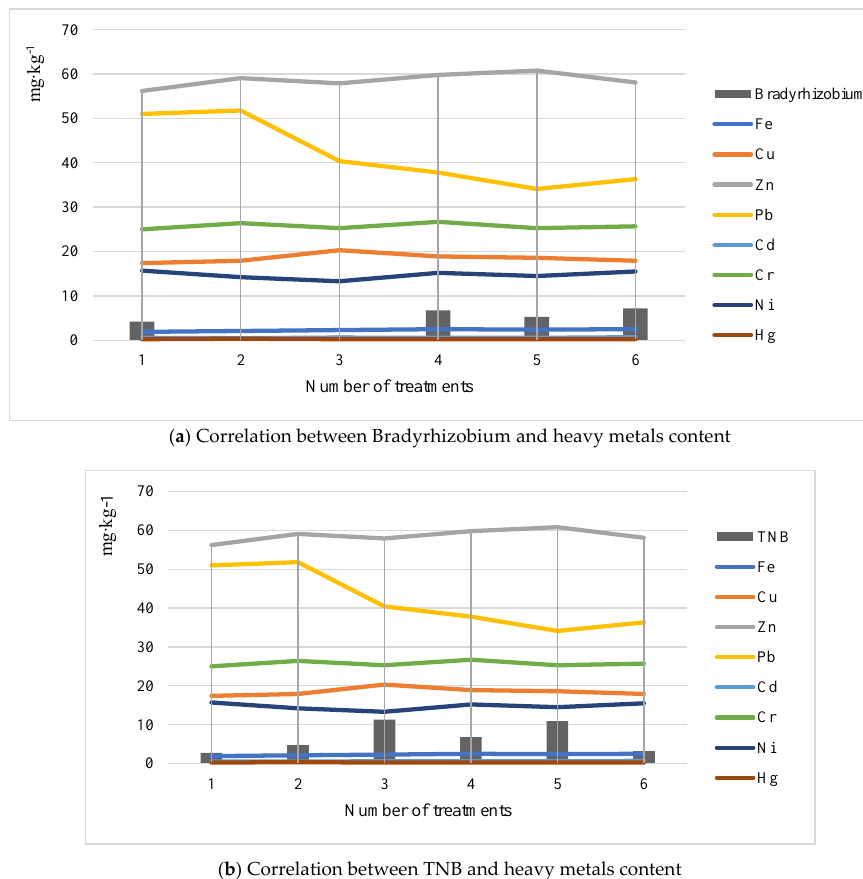
Figure 2. Effects of heavy metals content on bacterial growth. TNB (·10 7 in cfu/g). Bradyrhizobium (·10 3 in cfu/root nodule).